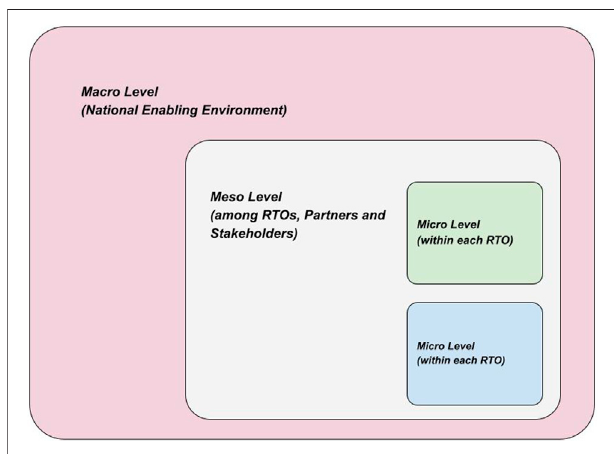
FIGURE 2 | Multi-level Policy Map. *source of diagram idea: Van Notten (2006). Remade by author for new